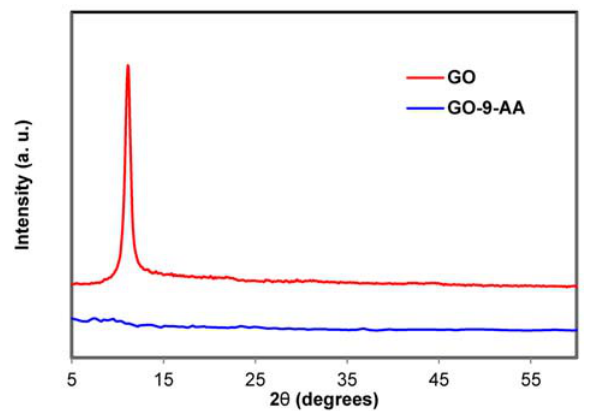
Fig. 4. X-ray diffraction patterns of GO and GO-9-AA